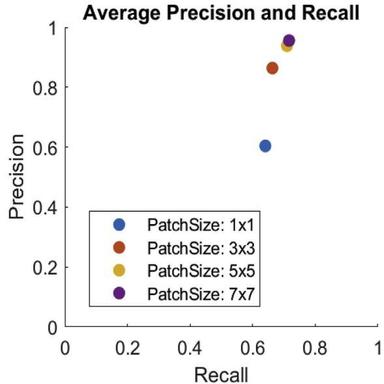
Average precision and recall for the detection of defects against sound regions.